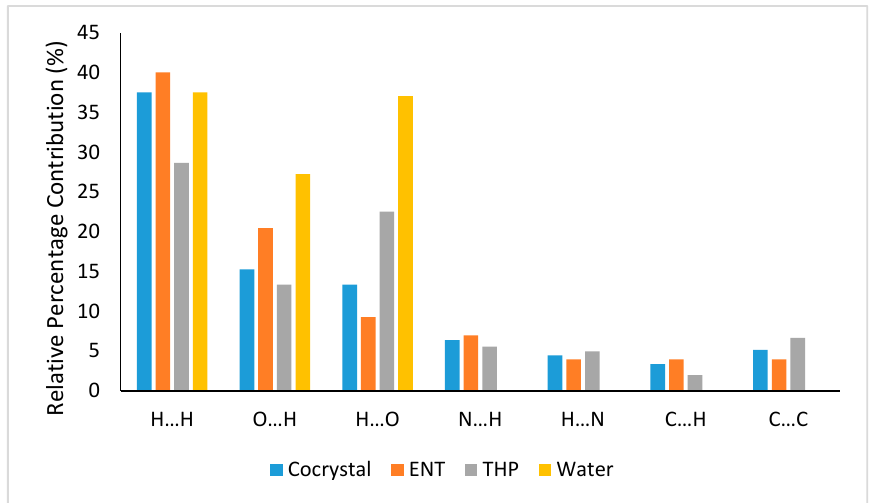
Figure 6. Relative percentage contributions of most important close contacts to the overall Hirshfeld surface for the cocrystal and individual components (ENT, THP, water).